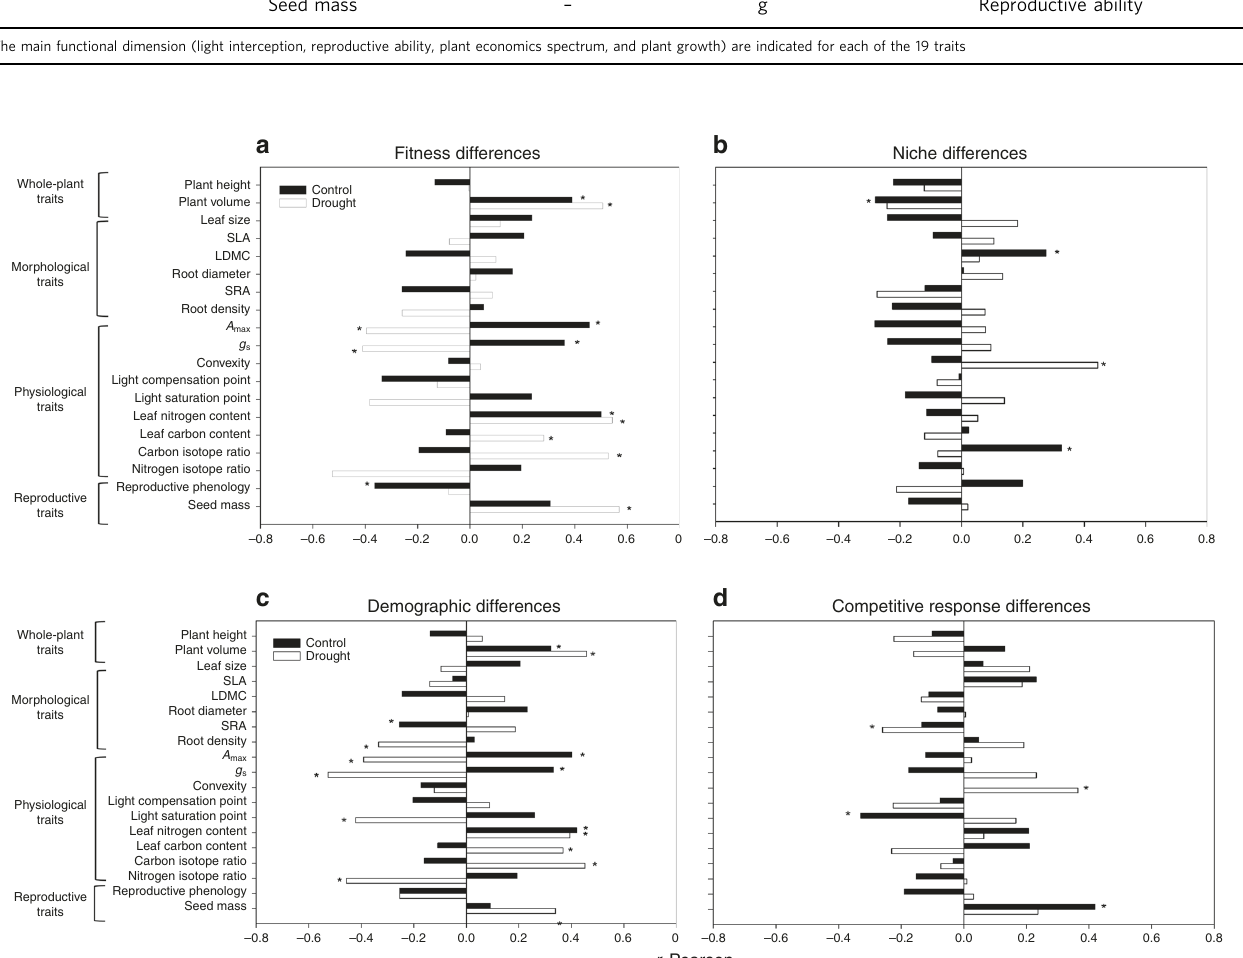
Fig. 1 Functional traits as predictors of the determinants of competitive outcomes. Horizontal bars denote single r -Pearson values for correlations between the 19 functional traits considered in this study and average fi tness ( a ) and stabilizing niche differences ( b ) as a function of climatic conditions (control and drought treatments with black and white bars, respectively). Trait correlations with the two components of fi tness differences, the demographic ratio and the competitive response ratio, have been also represented ( c and d ). The functional traits that exercised a signi fi cant effect ( p < 0.05) following Benjamini – Hochberg corrections for multiple comparisons have been marked with